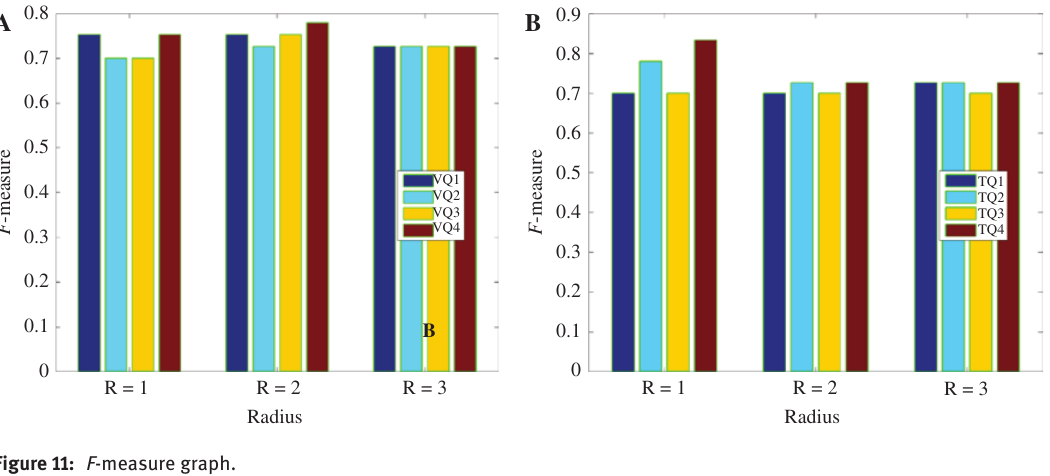
Figure 11: F -measure graph. (A) Video queries. (B) Text queries.